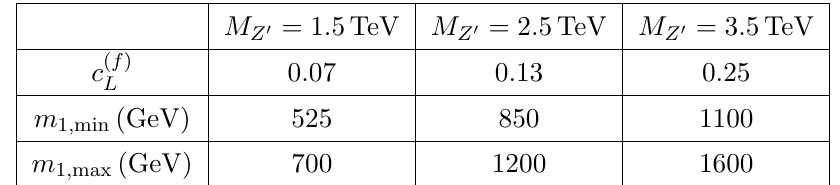
Table 1 . Allowed range of m (equivalent to k (cid:0) 1 =